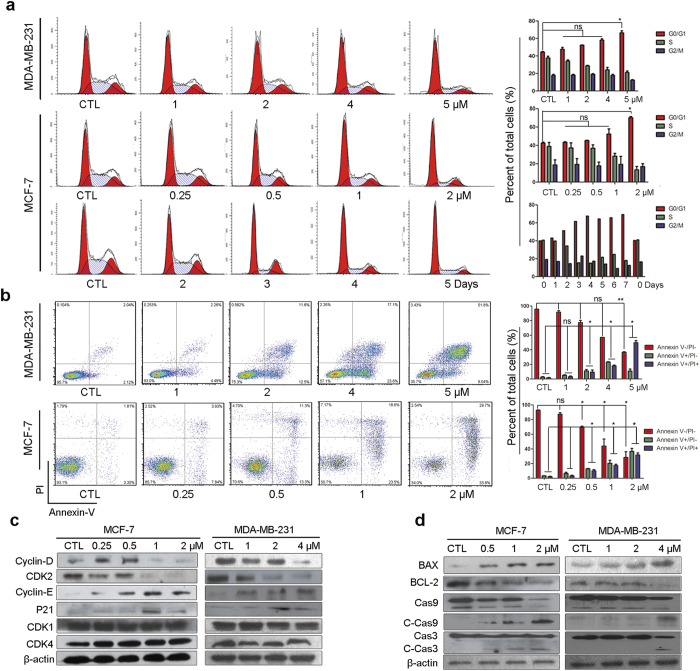
Induction of G0/G1 phase arrest and apoptosis by ZLD1039 treatment in breast cancer cells in vitro.(a) ZLD1039 induced G0/G1 phase arrest of MCF-7 and MDA-MB-231 cells. MDA-MB-231 cells (up) and MCF-7 cells (middle) were treated with indicated concentration of ZLD1039 for 4 days, and MCF-7 cells (down) were treated with ZLD1039 (2 μM) for indicated days, and then cell-cycle distribution was analysed by flow cytometry (FCM). Percentages of the cell cycle are presented (right). Values are mean ± SD (n = 3); ns, not statistically significant; *P < 0.05 among groups. (b) FCM analysis of cells stained with Annexin V- FITC/PI after treatment with various concentrations of ZLD1039 for 4 days. Quantified values of apoptosis are shown (right). Results are mean ± SD of three independent experiments; ns, not statistically significant; *P < 0.05 and **P < 0.01 among groups. (c,d) Cells were treated with various concentrations of ZLD1039 for 4 days and proteins were analysed using immunoblot analysis. Cas9, pro-caspase 9; C-Cas9, cleaved-caspase 9; Cas3, pro-caspase 3; C-Cas3, cleaved-caspase 3.